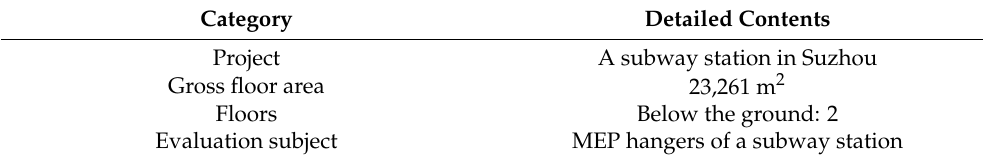
Table 1. Case project overview.